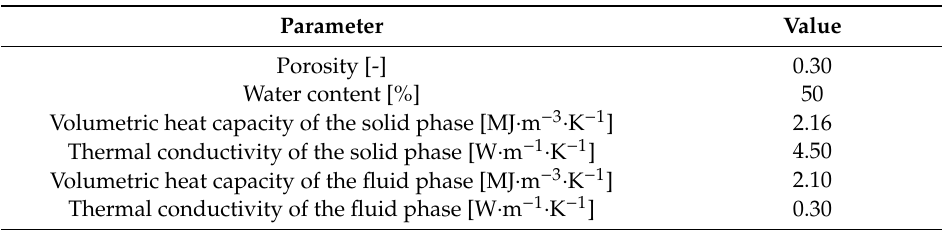
Table 2. Physical properties of the soil in the numerical